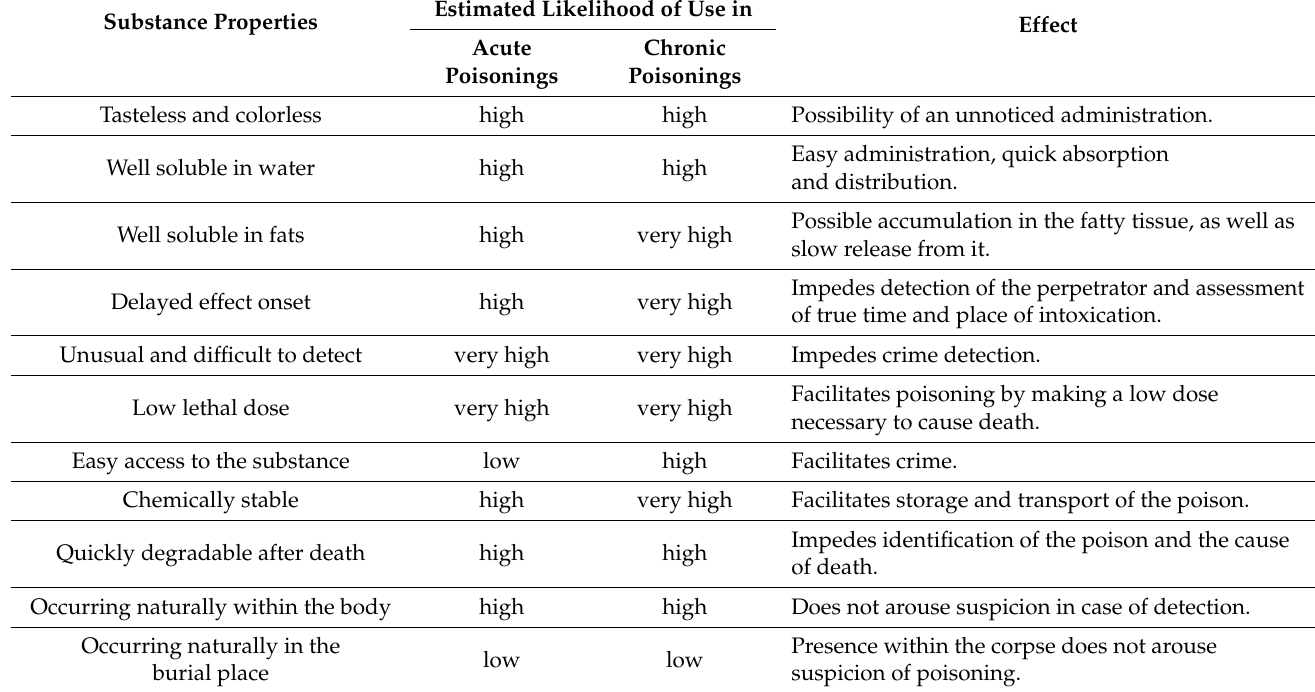
Table 1. Properties of pharmacologically active substances facilitated criminal poisoning